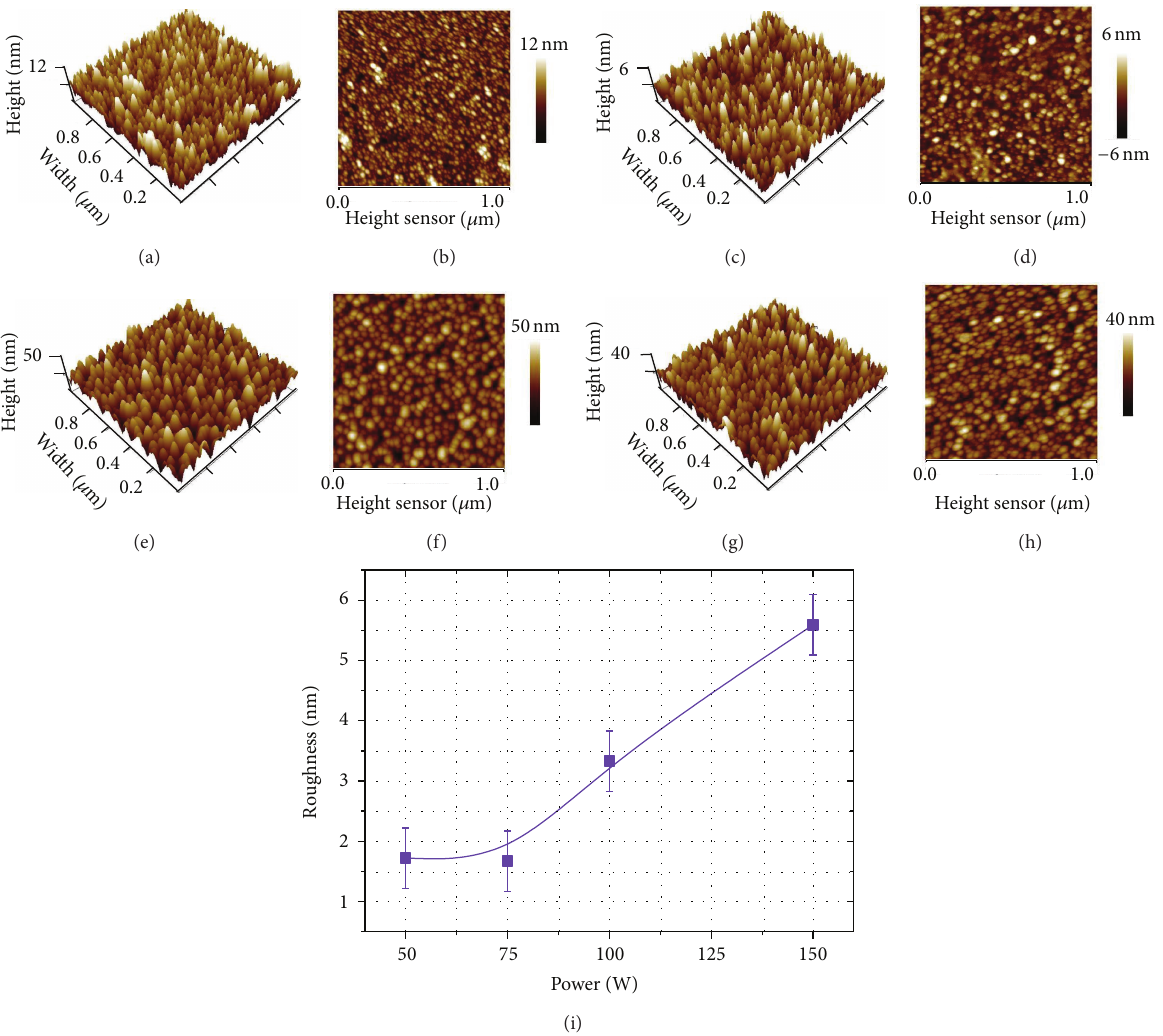
Figure 4: Atomic force microscope (AFM) 3D images for the ZnO thin films with different RF powers of (a) 50, (c) 75, (e) 100, and (g) 150W; (b), (d), (f), and (h) are the corresponding 2D surface images for (a), (c), (e), and (g) forms, respectively. The scanning size of all domain images was fixed at 1 × 1 𝜇 m 2 . (i) The surface roughness values as a function of the ZnO thin films with different deposition powers ranged from 50 to 150